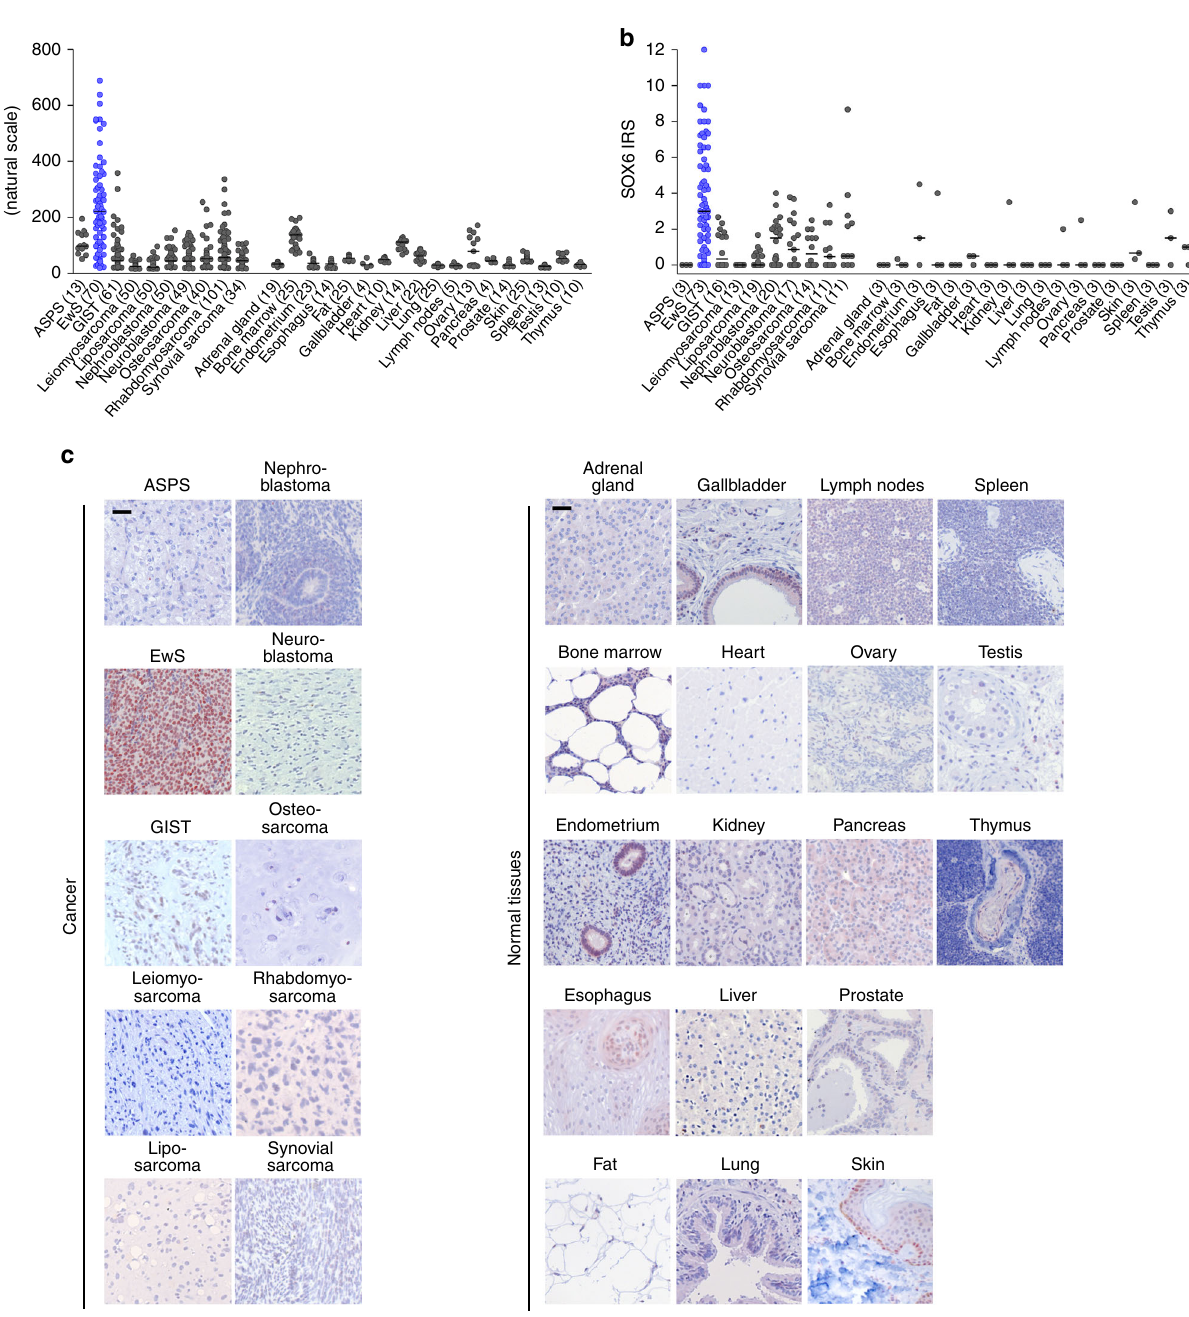
Fig. 1 SOX6 is highly but variably expressed in EwS. a SOX6 expression levels (Affymetrix microarrays) in EwS tumors, nine additional sarcoma or pediatric tumor entities, and 18 normal tissue types. Data are represented as dot plots, horizontal bars represent medians. The number of biologically independent samples per group ( n ) is given in parentheses. ASPS, alveolar soft part sarcoma; GIST, gastrointestinal stromal tumor. b Validation of SOX6 protein expression by IHC in the same tissue types as shown in ( a ). Immuno Reactive scores (IRS) are presented as dot plots. Horizontal bars represent medians. The number of biologically independent samples per group ( n ) is given in parentheses. c Representative micrographs of the IHC stains from samples of the same tumor entities or normal tissue types indicated in ( b ); scale bars = 20 µ m. Source data are provided as a Source Data fi